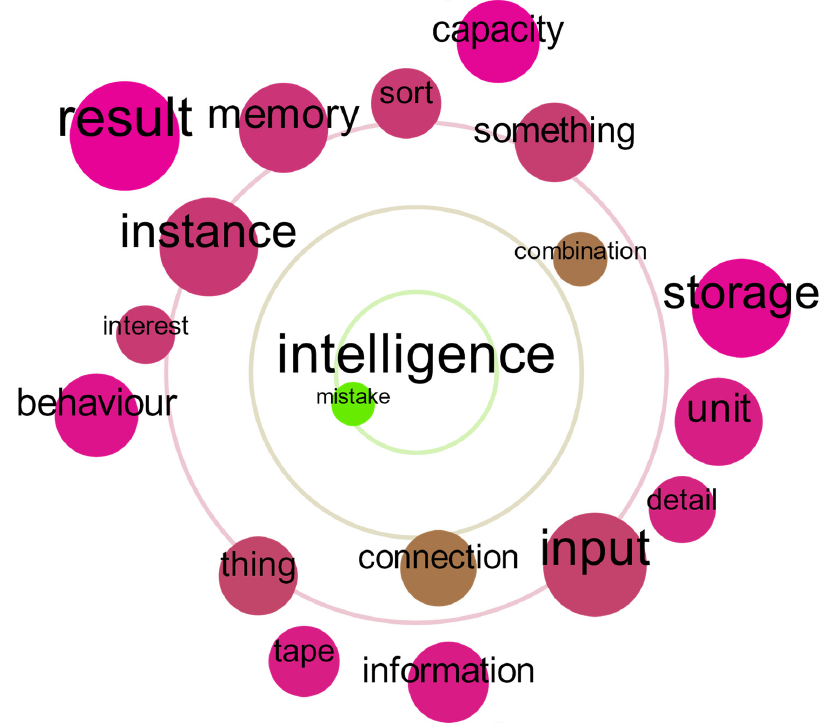
Figure 1. Terms semantically close to “intelligence”. Font and circle sizes correspond to the term frequency in the corpus, while distances reflect semantic similarity.